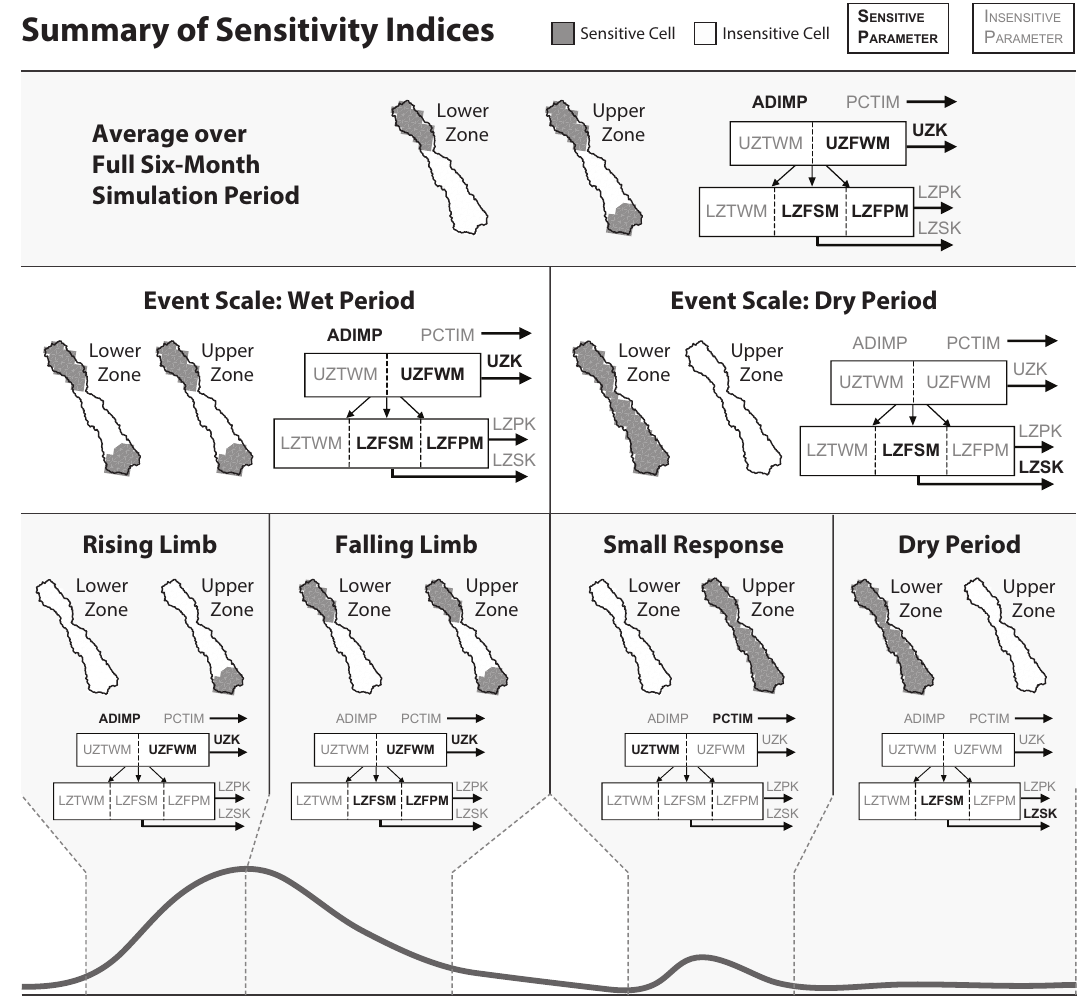
Fig. 9. Qualitative summary of sensitivity indices for the RMSE metric at increasing temporal resolutions, from the aggregated simulation period (top), to the event scale (middle), and the high-resolution moving window (bottom). Each classification includes spatial maps showing where upper zone and lower zone parameters are sensitive in the watershed, along with a model diagram highlighting the most sensitive parameters during the defined periods. Results shown for the high-resolution sensitivity analysis are a qualitative summary of insights gleaned from Figures 6–8 and thus do not reflect the dependence of time-varying sensitivity on the spatial distribution of precipitation.